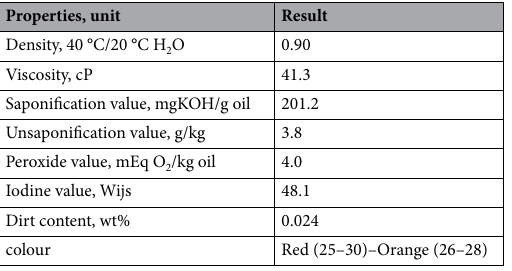
Table 1. Average physicochemical properties of crude palm oil source